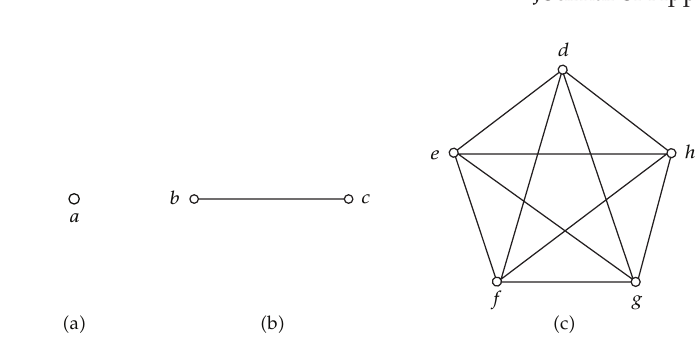
Figure 1: The complete graphs of equivalence